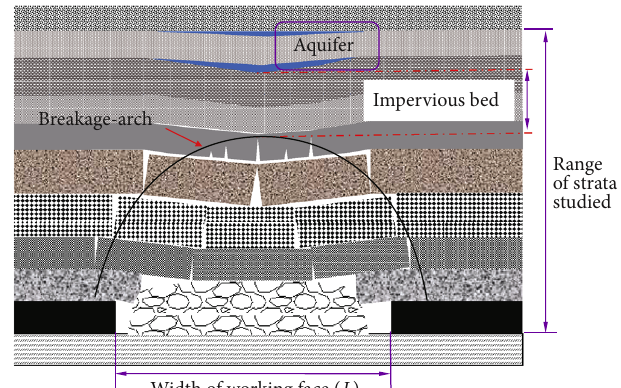
Figure 1: Spatial structure model of water inrush.